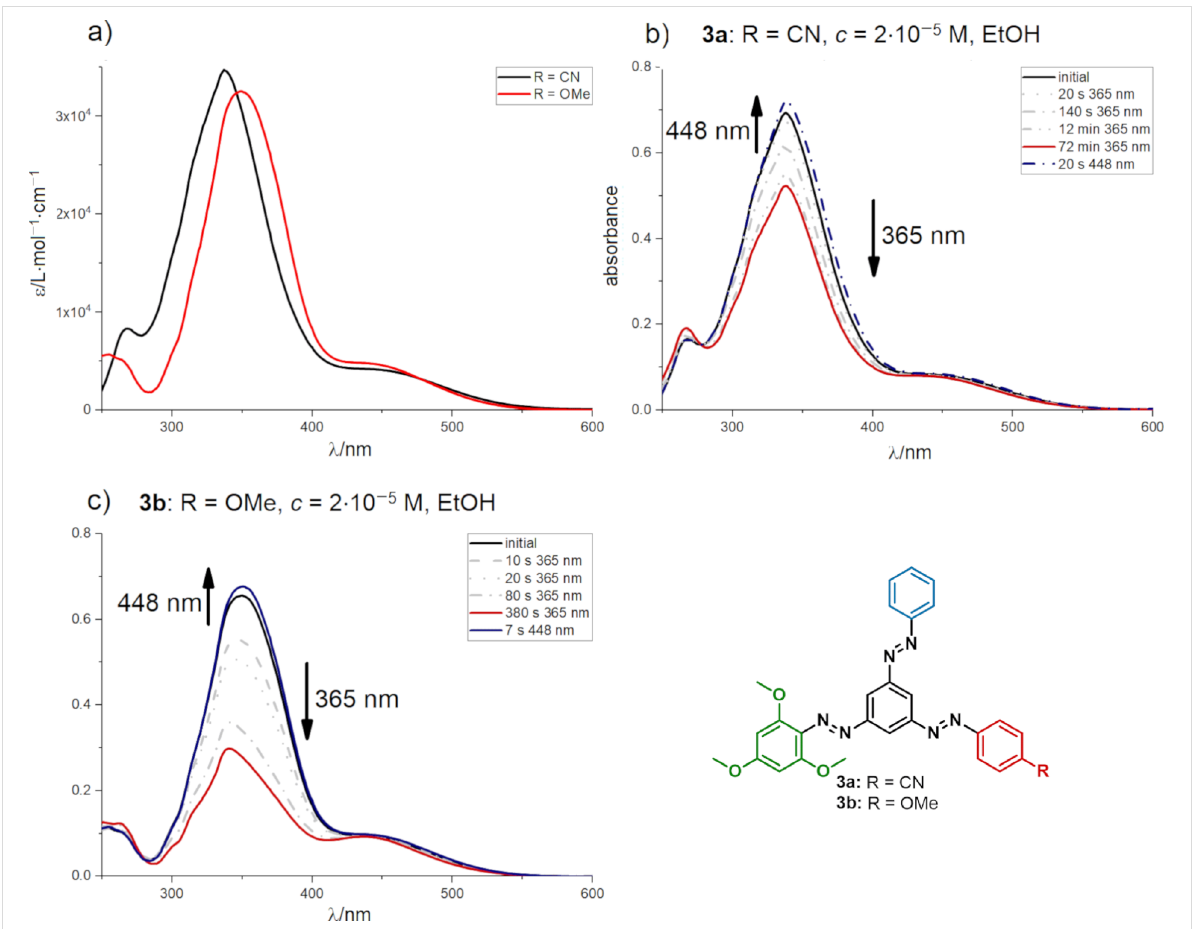
Figure 2: a) UV–vis spectra of tris(arylazo)benzenes 3a / 3b in ethanol. b) Reversible photoisomerization of 3a and c) 3b using light of 365 nm wave- length to induce E → Z isomerization and of 448 nm wavelength for photochemical